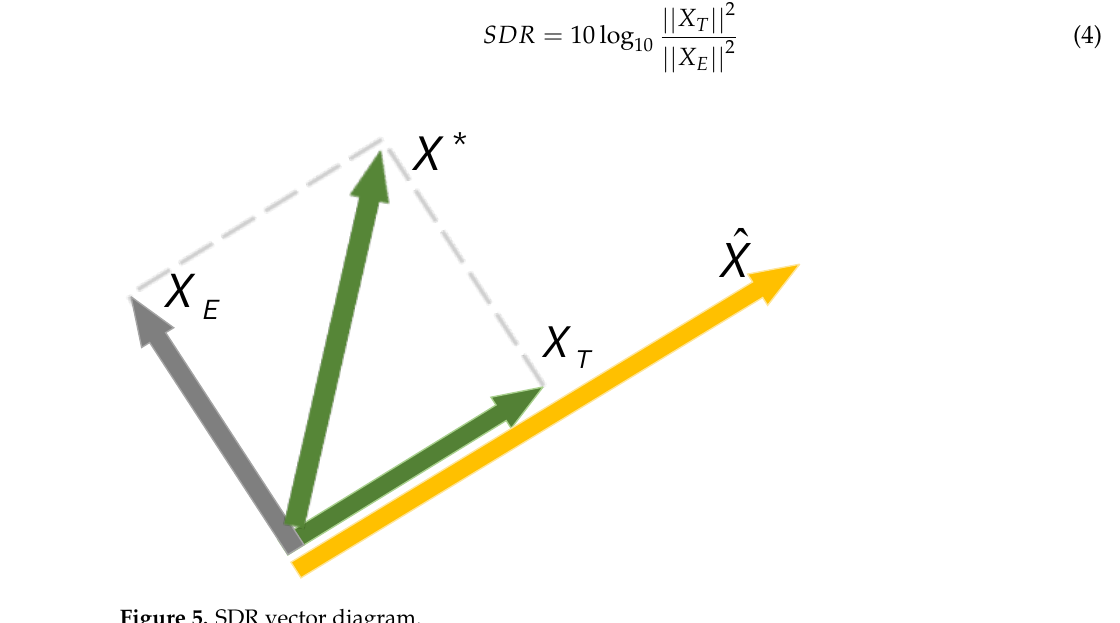
Figure 5. SDR vector diagram. Table 2. Meaning of SDR